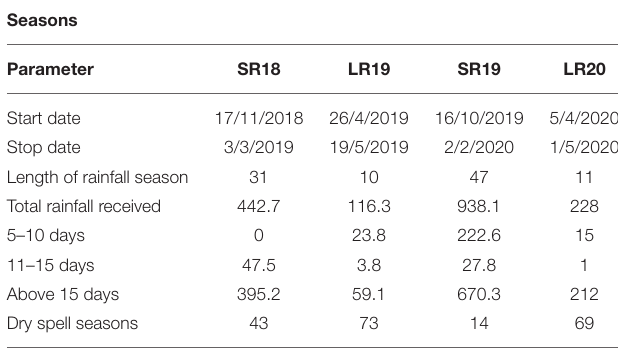
TABLE 2 | Seasonal Rainfall characteristics for short rains 2018 and 2019 and long rains 2019 and